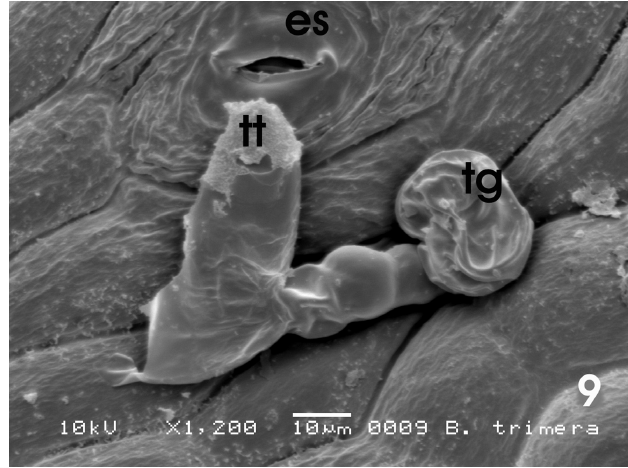
FIGURA 6 – B. trimera – Vista frontal da epiderme da ala dos cladódios. es: estômato. Barra = 20 µ m.